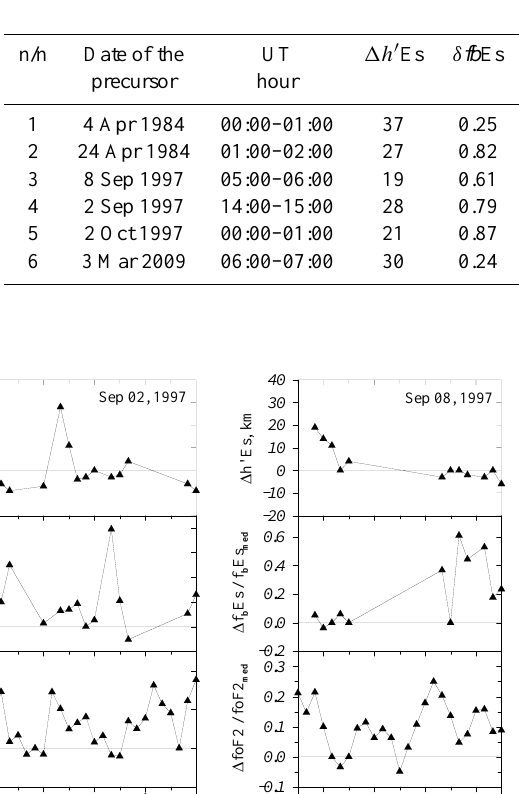
Table 2. Revealed ionospheric precursors and corresponding earthquakes. Lead times 1T for the precursor occurrence and daily Ap indices are given as well.